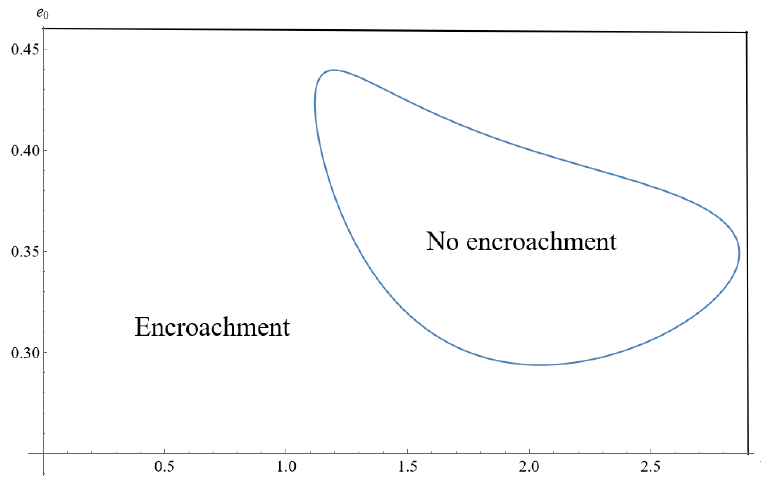
Figure 3. Impact of the initial unit amount of carbon emissions and unit carbon price on manufac- turer’s encroachment decision.